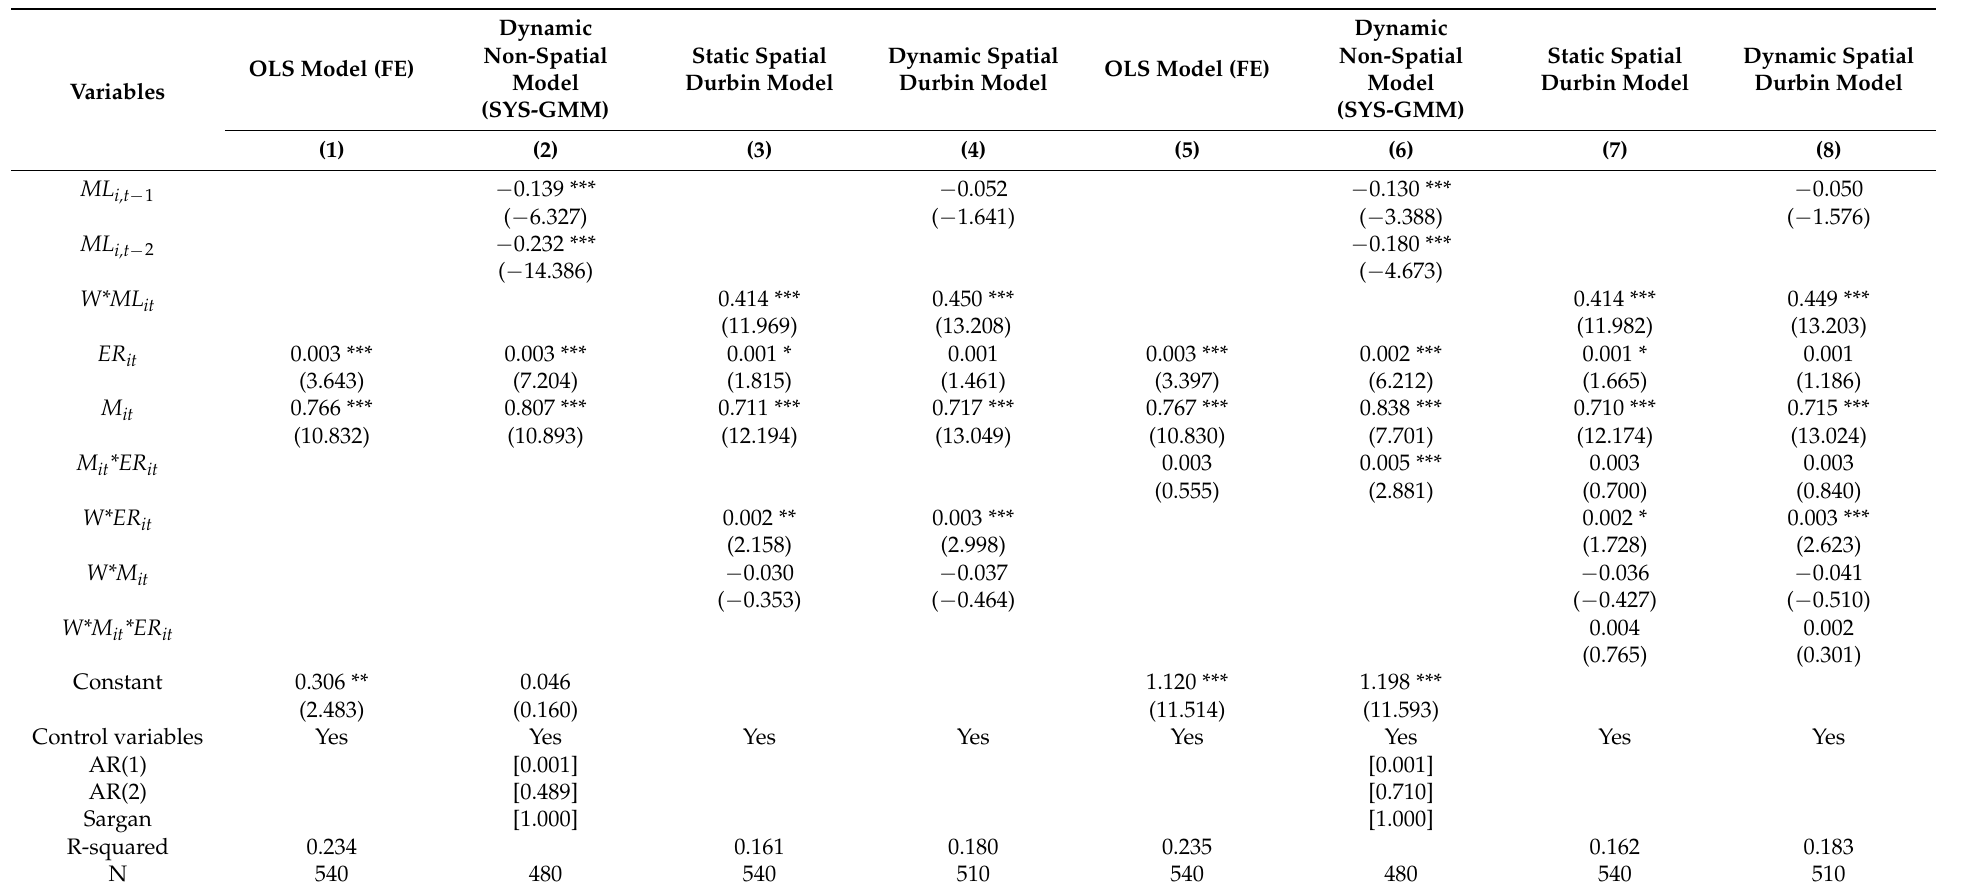
Table 5. The moderating results of efficiency change for the nexus between market-incentive environmental regulation and green